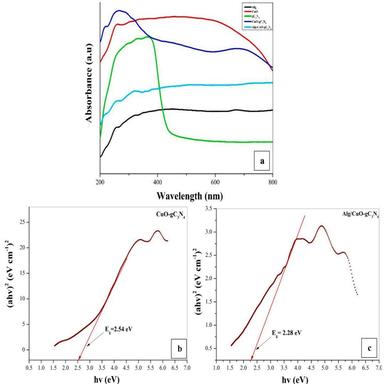
(a) UV DRS spectra of Alg, CuO, gC3N4, CuO-gC3N4 and Alg/CuO-gC3N4; Tauc plot of (b) CuO-gC3N4 and (c) Alg/CuO-gC3N4.